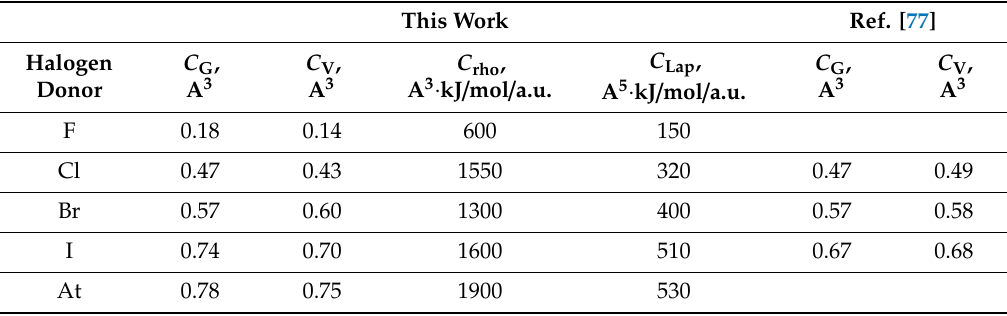
Table 2. The numerical values of fitted parameters C G , C V , C rho and C Lap used in Equation (9) to fit data points shown in Figures S3–S6. For comparison, several correlation coe ffi cients previously reported in [77] are added to the last two